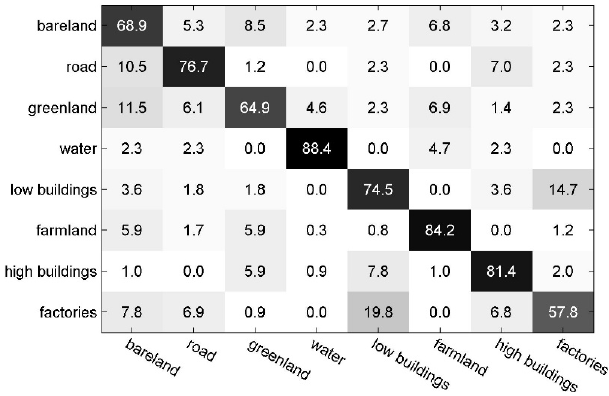
Figure 8. Confusion matrix of the classification result based on the CTS on Scene-TZ.